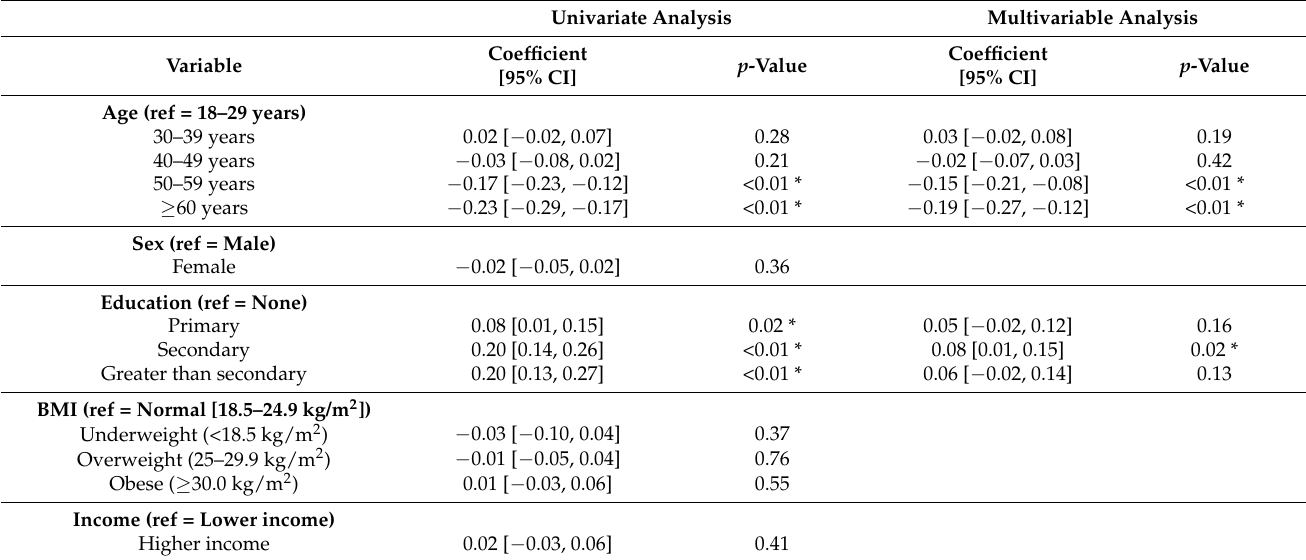
Table 5. Associations between sociodemographic characteristics and number of days per week consuming sugar-sweetened beverages among the study population.